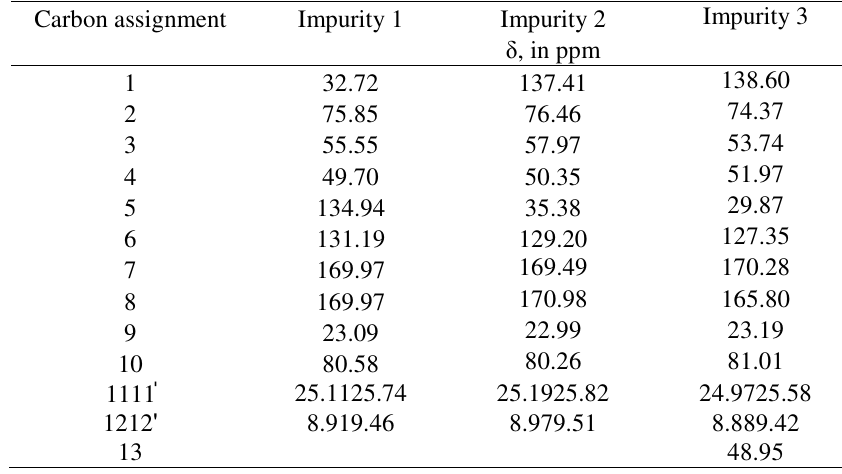
Table 3. 13 C NMR spectral data of impurities 1, 2 &